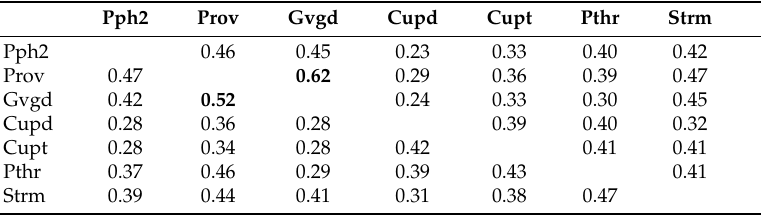
Table 1. The inner consistency between pairs of p-tools measured by the K all index, set to work with a 5% percentage equality threshold. The elements above the diagonal correspond to the BRCA1-SGE dataset while the elements below it correspond to the BRCA1-HDR dataset. The P-tools abbreviations are: Polyphen(Pph2), Provean (Prov), Align GVGD (Gvgd),